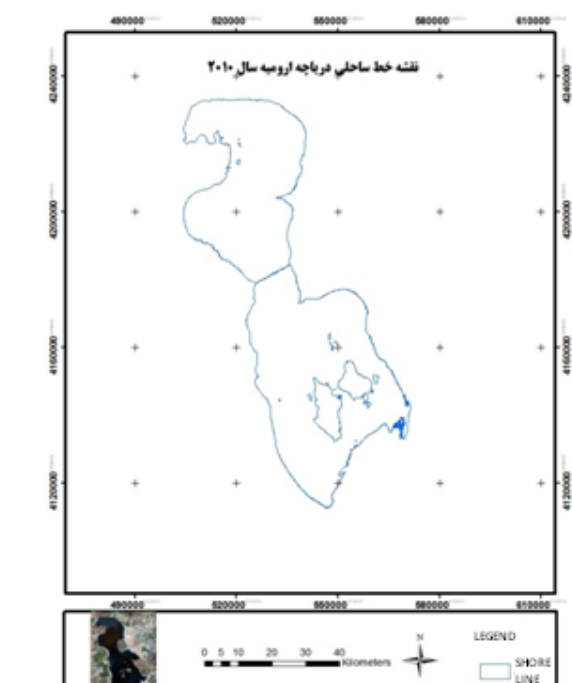
Figure 12: Urmia lake shoreline in 2000